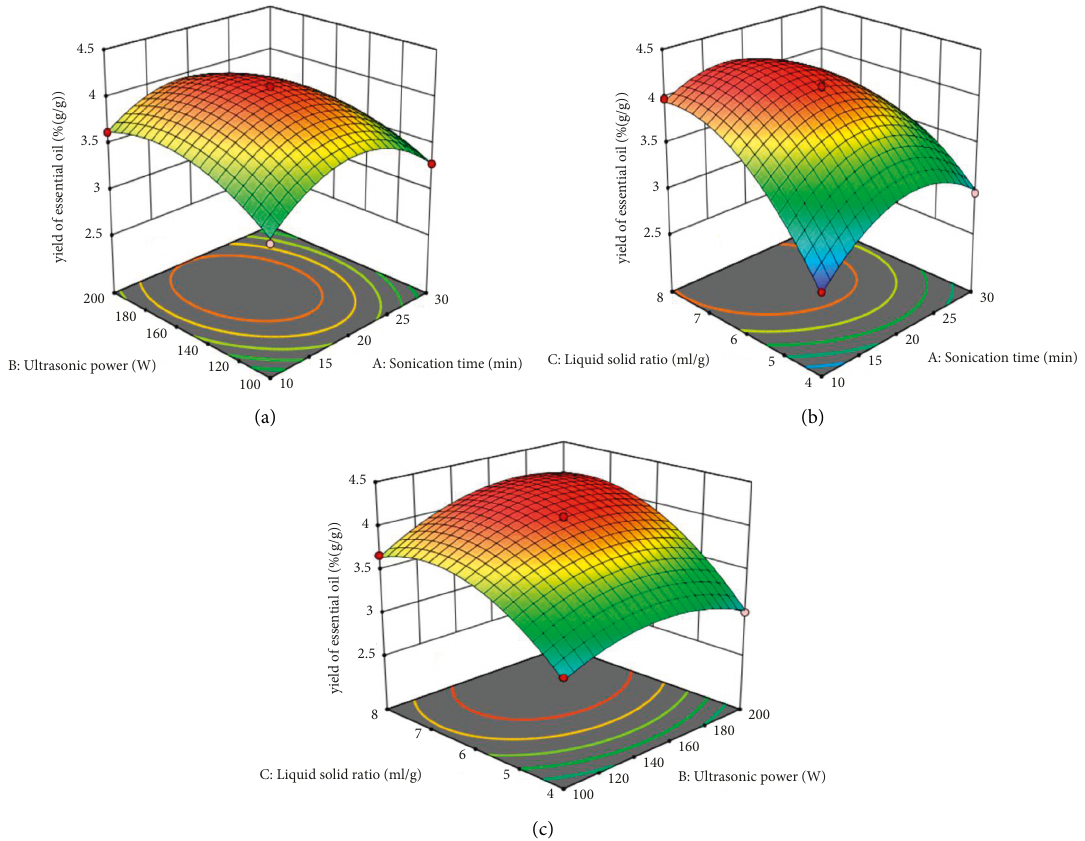
Figure 2: 3D response surface plot of the yield of EO: (a) effects of sonication time and ultrasonic power at the constant liquid-solid ratio, (b) effects of sonication time and the liquid-solid ratio at constant ultrasonic power, and (c) effects of ultrasonic power and the liquid-solid ratio at constant sonication